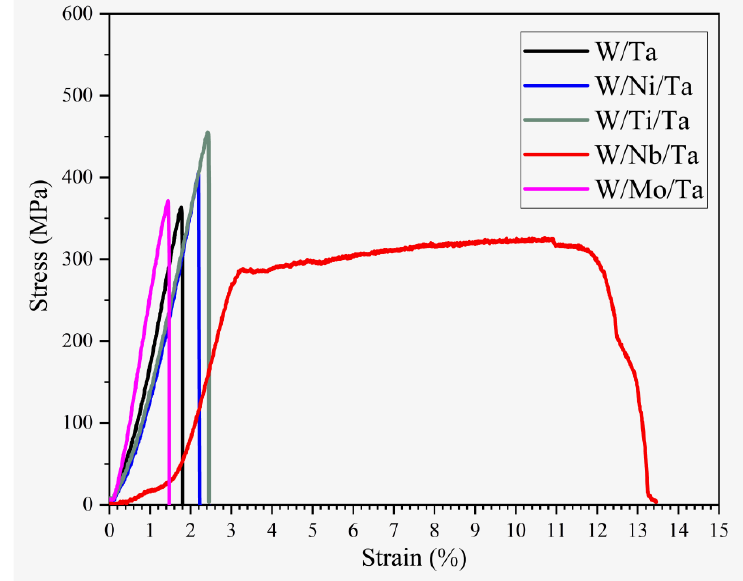
Figure 3. Tensile test strain-stress curves of W-Ta laminates with different transition layers. Table 3. The strength and the integral of varies W-Ta laminates.